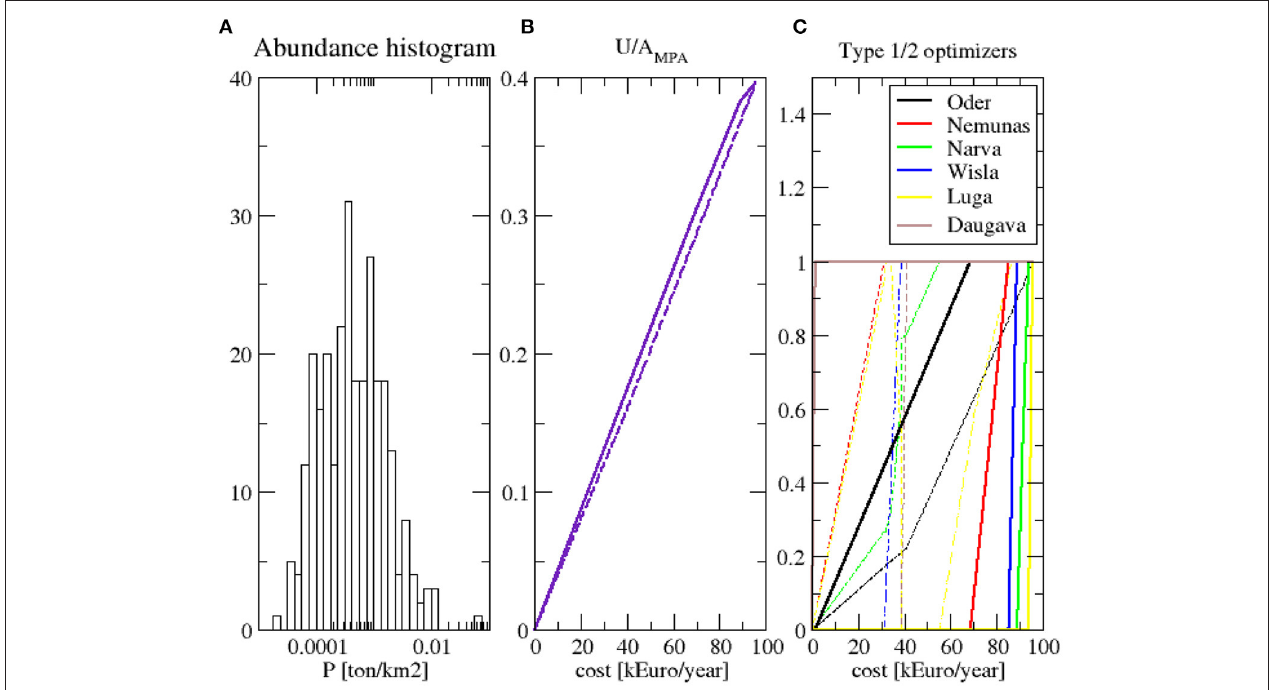
FIGURE 9 | (A) Histogram of average Baltic macro plastic density on assessment grid within Natura 2000 MPAs in Figure 4 . (B) MPA integrated benefit of cleanup per area U / A MPA as function of cost for fixed-objective (type 1, dashed line) or best-value-per-cost (type 2, full line). End point on dashed curve correspond to at least 25% local pollution reduction at all feasible points on assessment grid. For the plot we applied P † = < P > MPA so BAU reference scenario ( f = 0) corresponds to U / A MPA = 0 and full cleanup ( P ( x ) = 0) of all sources (also beyond 6 river in Table 1 corresponds to U / A MPA = 1 (C) Cost-minimizing solution f for different river sources in Table 1 corresponding to B ) for type 1 optimization (dashed curves) and type 2 optimization (full